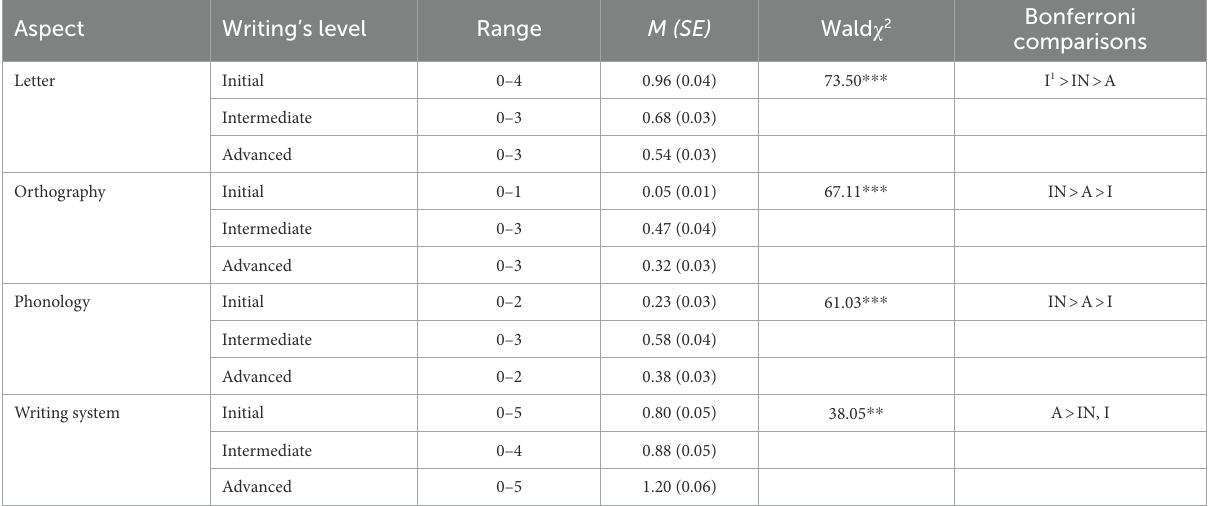
TABLE 1 Differences in the sum of parents’ references to the different writing levels ( N =